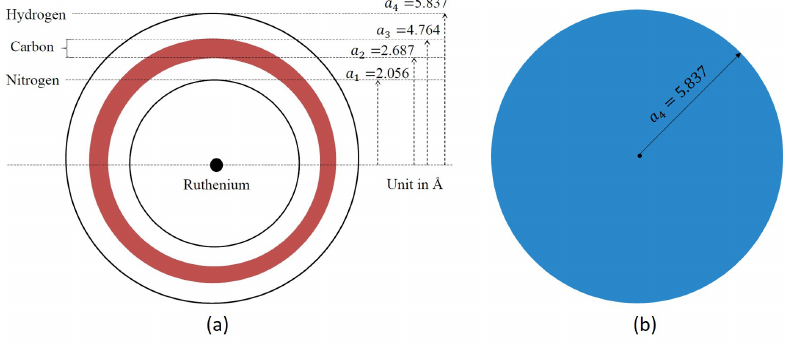
Figure 2. Two models for Ru(bpy) 2 + Solid